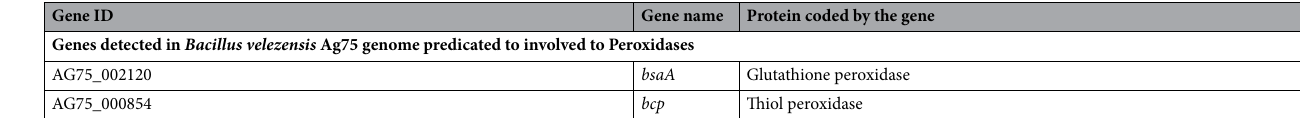
Table 3. Genes detected in Bacillus velezensis Ag75 genome predicated to be involved in plant growth- promoting activity.